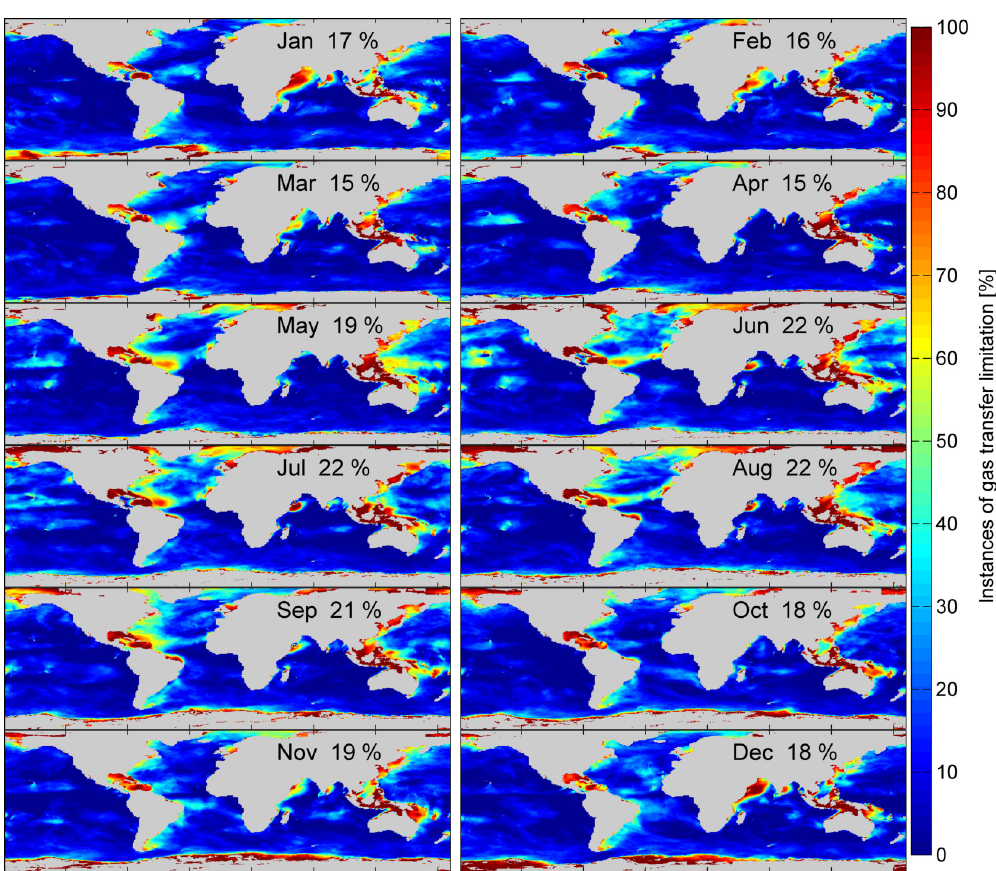
Figure 7. The global probability of experiencing gas transfer suppression during the respective month (2014). The percentage is the number of gas transfer suppressed occurrences with respect to the total datapoints with a 3h resolution.